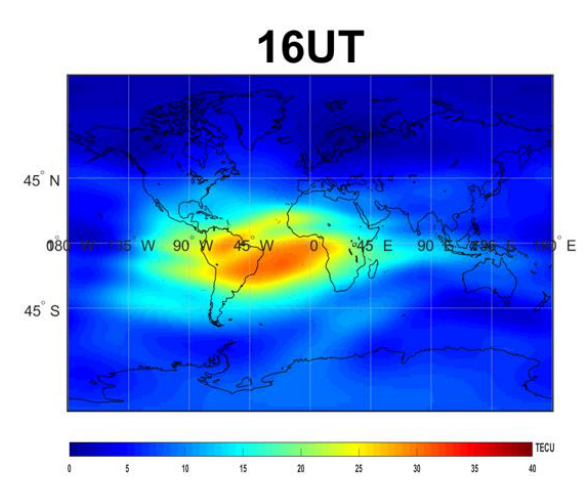
Figure 3 . VTEC-Map at UT = 16 on 1 st January 2018.